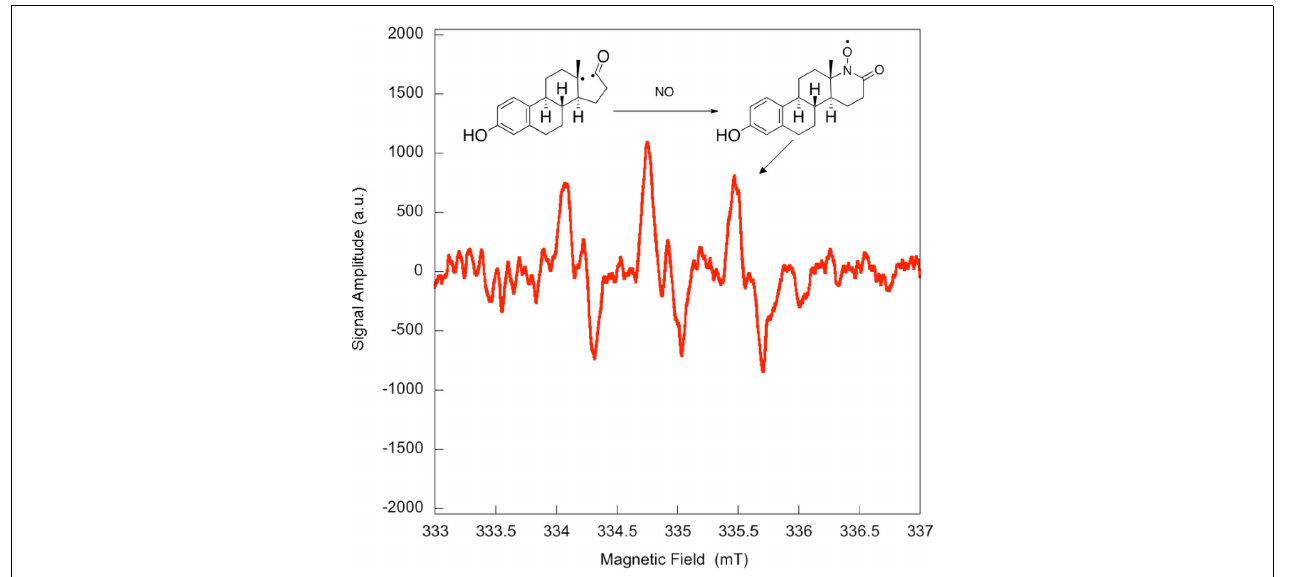
FIGUREA1 | Quenching of the transient bi-radical by nitric oxide. Electron paramagnetic resonance spectrum obtained upon irradiation of a 5 × 10 − 4 -M solution of estrone in acetonitrile under UV-B. A solution of estrone (0.5mM) dissolved in acetonitrile was degassed with nitrogen in order to avoid in situ formation of nitric dioxide.The solution was then saturated with a mixture containing 5% nitric oxide in nitrogen, and was allowed to flow through a conventional Electron paramagnetic resonance